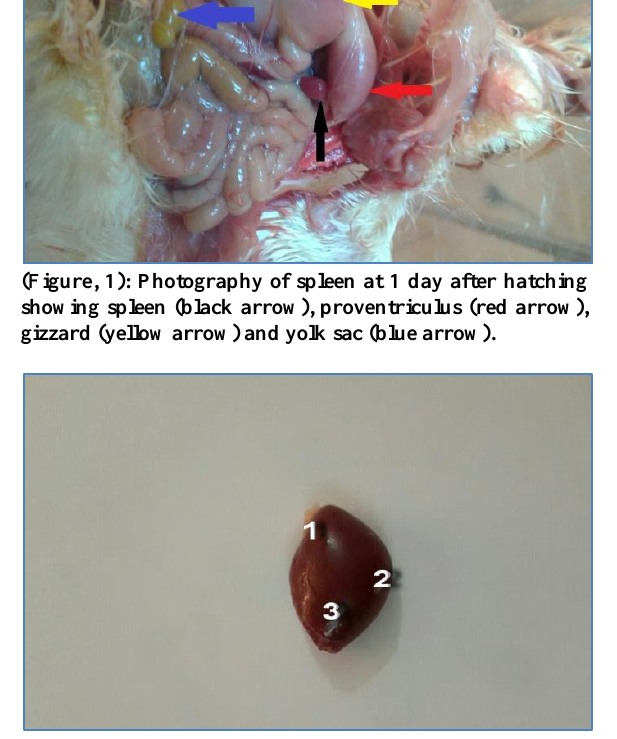
Figure, 2: Photography of spleen at 60 day showing 1.hillus, 2. Free surface and 3. Lateral surface.